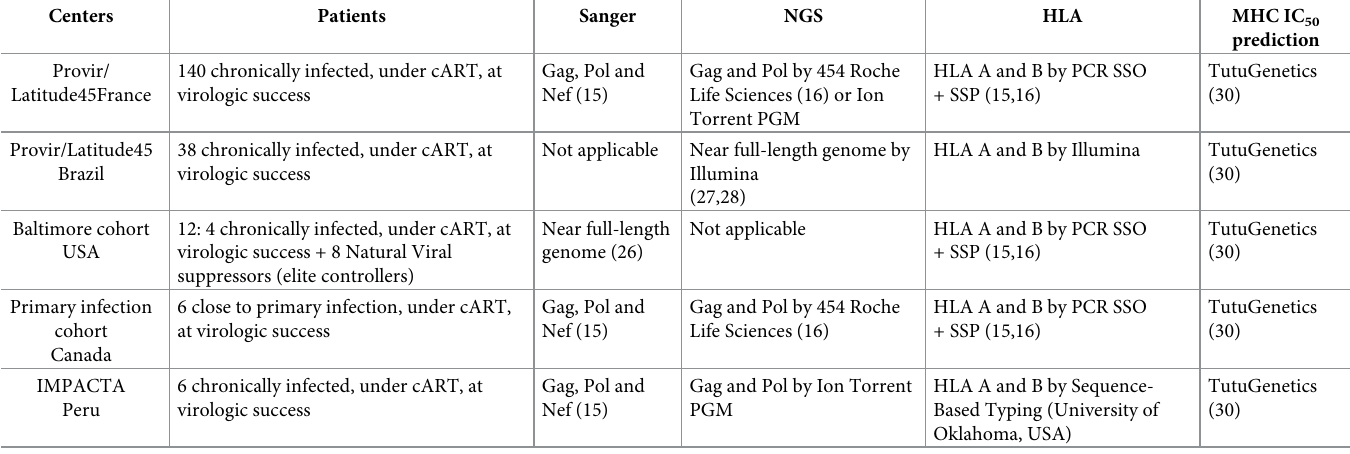
Table 3. Patients’ main characteristics and general technical strategy of study. Number of included patients, methods of HIV sequencing and HLA typing are described for each participating center. MHC IC 50 was predicted with TutuGenetics tool.